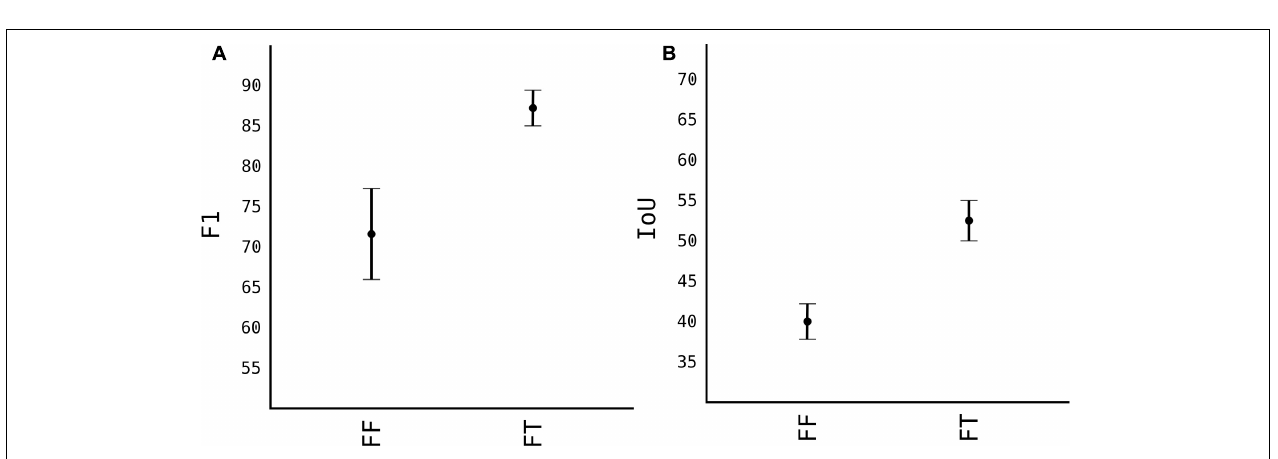
FIGURE 7 | Image augmentation and synthetic images results. (A) F1 accuracy score. (B) IoU accuracy score.